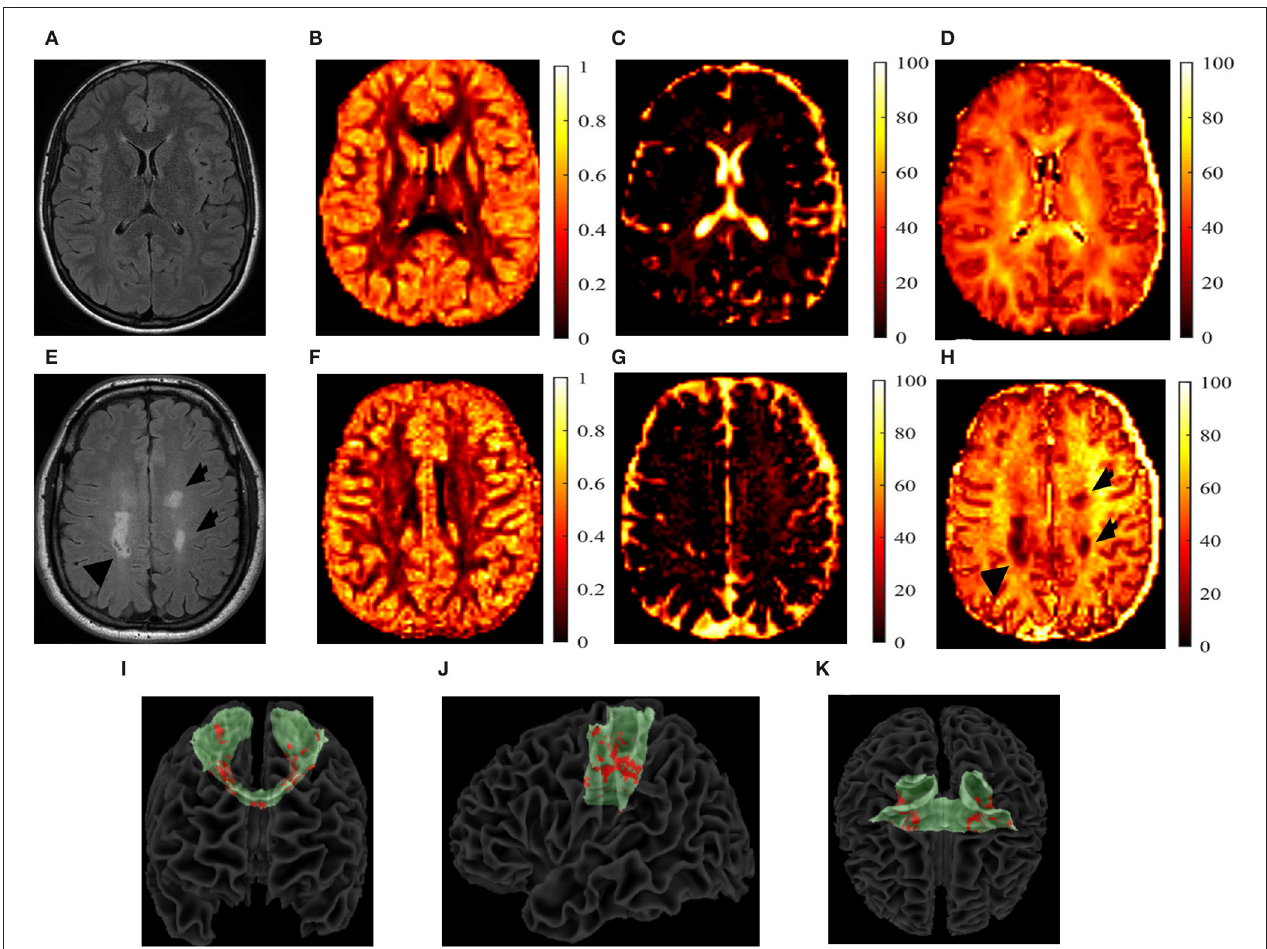
FIGURE 2 | T2-fluid-attenuated inversion recovery (FLAIR) images and the neurite orientation dispersion and density imaging (NODDI) parametric maps. T2-fluid-attenuated inversion recovery (T2-FLAIR) images and the neurite orientation dispersion and density index (NODDI) parametric maps of a 27-year-old, white, female healthy control (HC) (A–D) and a 40-year-old white person with relapsing-remitting multiple sclerosis (E–H) . The T2-FLAIR (A,E) , orientation dispersion index (ODI) (B,F) , isotropic volume fraction (IVF) (C,G) , and the neurite density index (NDI) (D,H) are shown. T2 lesions are indicated by black arrows. Reconstructed transcallosal fibers of the primary motor cortex are shown in green with both the T1 and T2 lesions shown in red with a coronal (I) , sagittal (J) , and axial (K) views. I-K show the coronal (I) , sagittal (J) , and axial (K) views of the reconstructed TC fibers of primary cortex in green, with lesions marked in red of a 56-year-old white male with secondary-progressive multiple